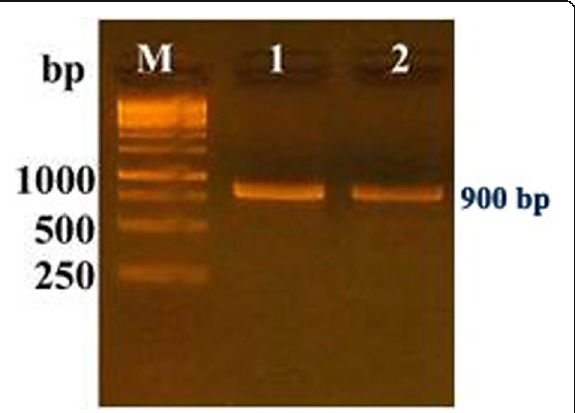
Fig. 1 PCR-amplified products from the internal transcribed